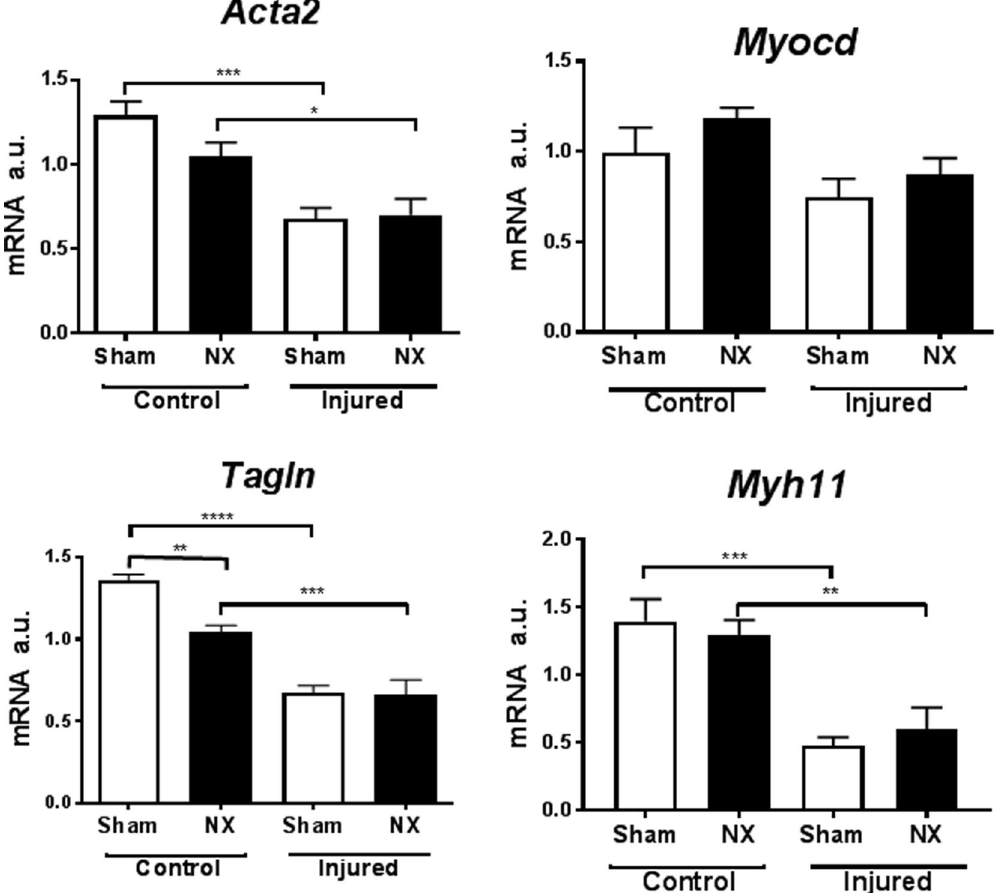
Figure 3. Wire injury, but not uremia, affects expression of smooth muscle marker genes in C57BL/6 mice. Real-time PCR analysis of carotid mRNA (pooled two and two) from sham-operated (sham) and uremic (NX) C57BL/6 mice, either with (Injured) or without (Control) wire-induced vascular injury. Gene expression was normalized to CANX. Bars indicate mean ± SEM (n = 6 per group); 1-way ANOVA followed by Sidak’s multible comparison test, * p < 0.05, ** p < 0.1, *** p < 0.001, **** p < 0.0001. a.u.: arbitrary units; Acta2 : Smooth